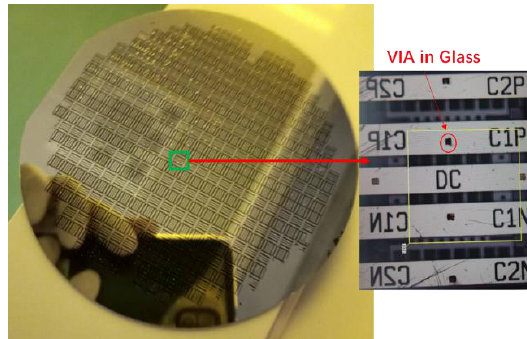
Figure 7. The processed accelerometers.